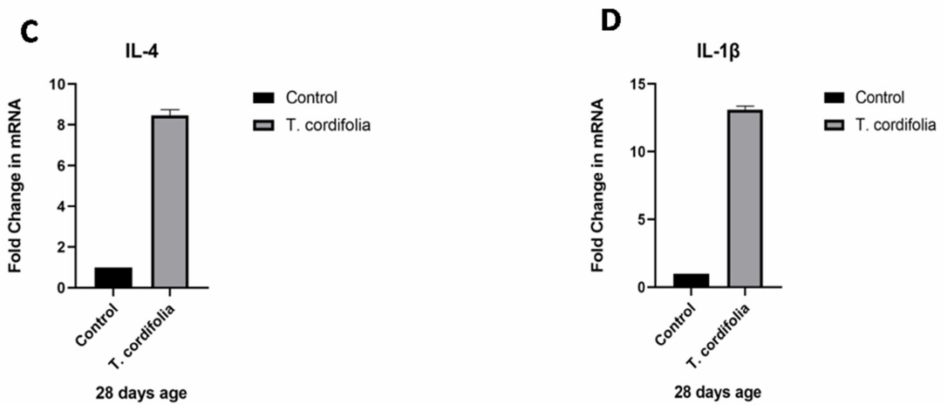
Figure 1. ( A – D ) Quantitative real-time PCR analysis of Immune response gene transcripts (expressed as fold change in the immune response gene transcripts) in PBMCs ex vivo in specific pathogen free (SPF) WL chickens post T. cordifolia treatment for 4 weeks. Table 3. Quantitative real-time PCR analysis of IL-2 expression in PBMCs of chickens challenged with very virulent, infections bursal disease virus (vvIBDV) at di ff erent days post challenge (DPC). S. number